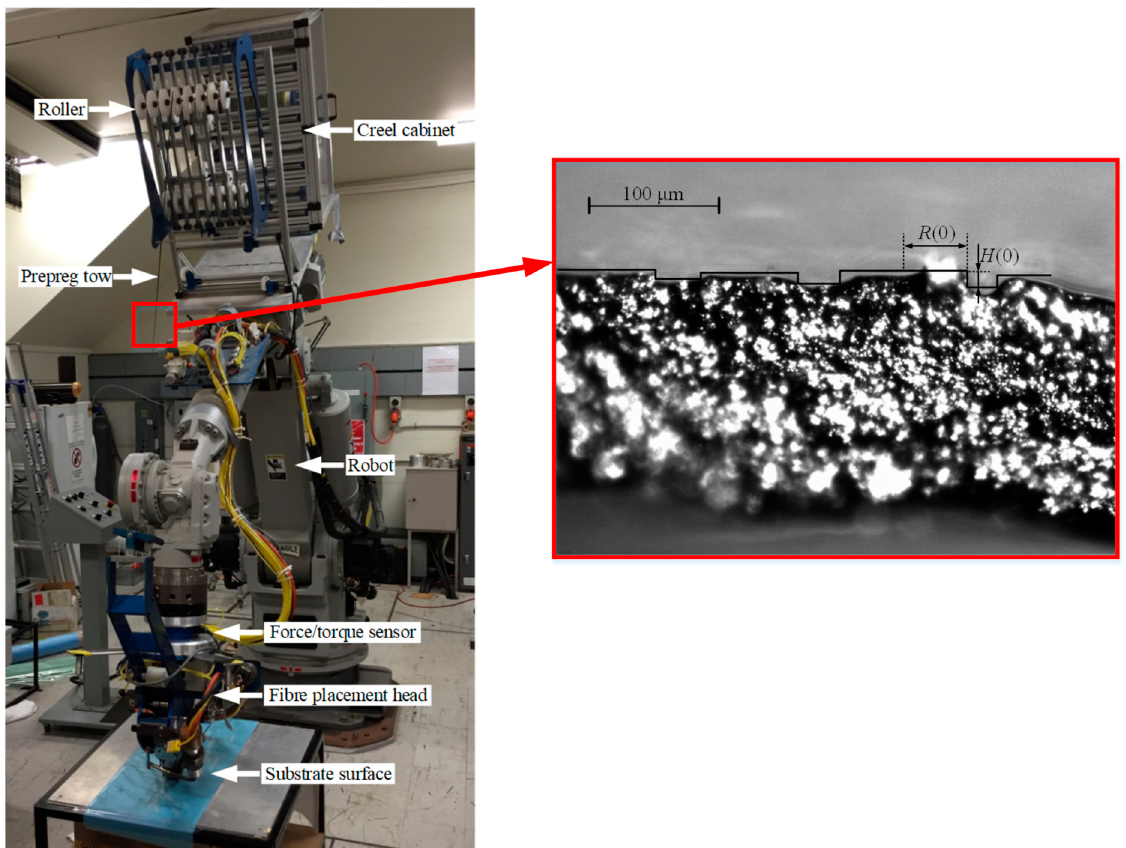
Figure 7. The RFP system and cross-sectional photomicrograph of prepreg tow.